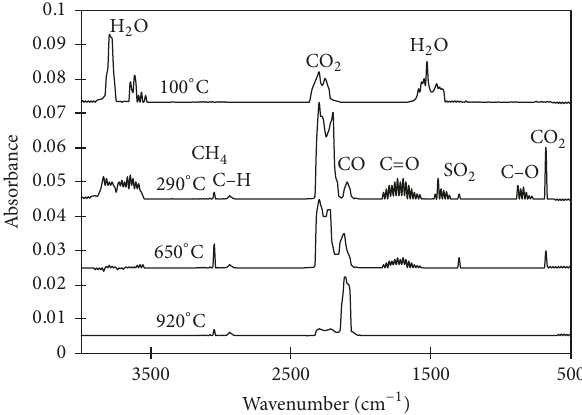
Figure 5: IR spectrum of gaseous products obtained from sediment pyrolysis at several selected